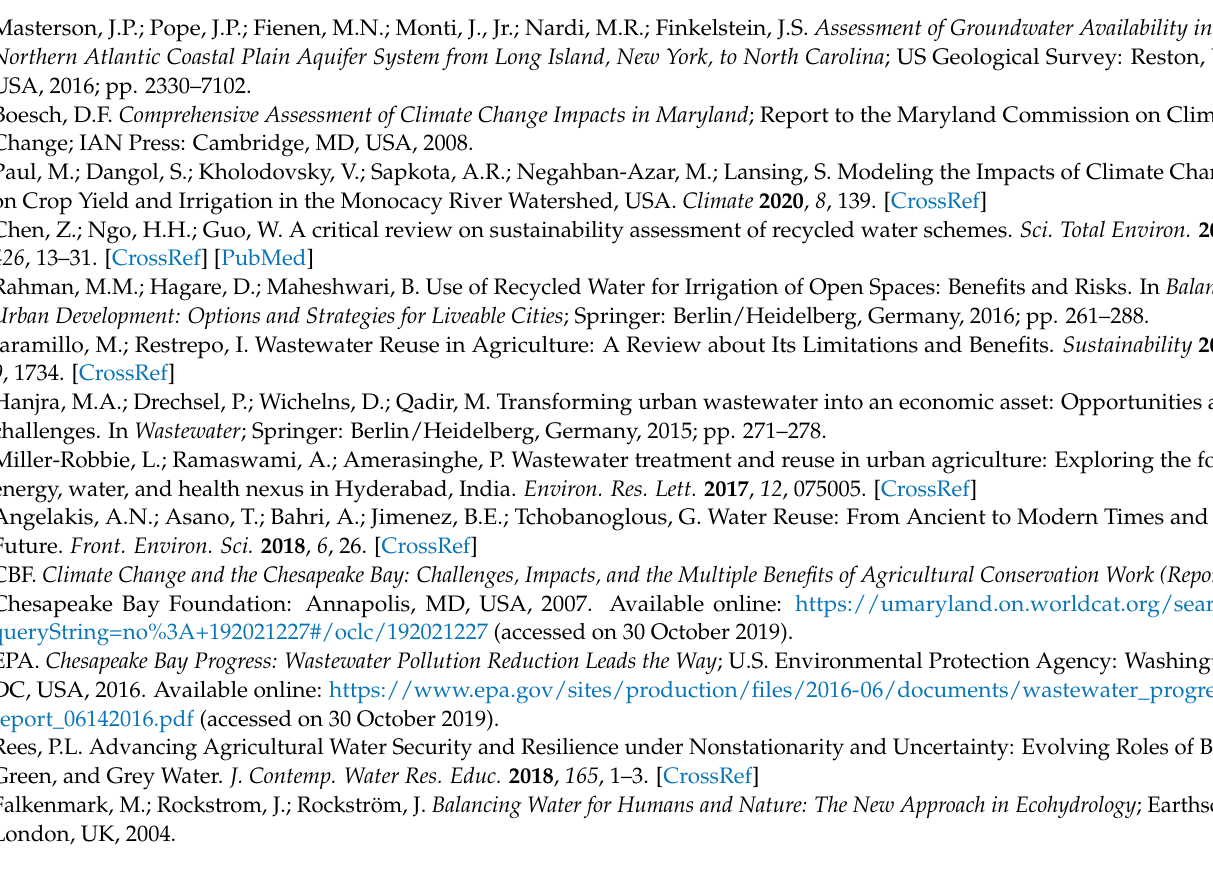
Figure A3. Number of wells that are categorized based on the permitted average withdrawal.